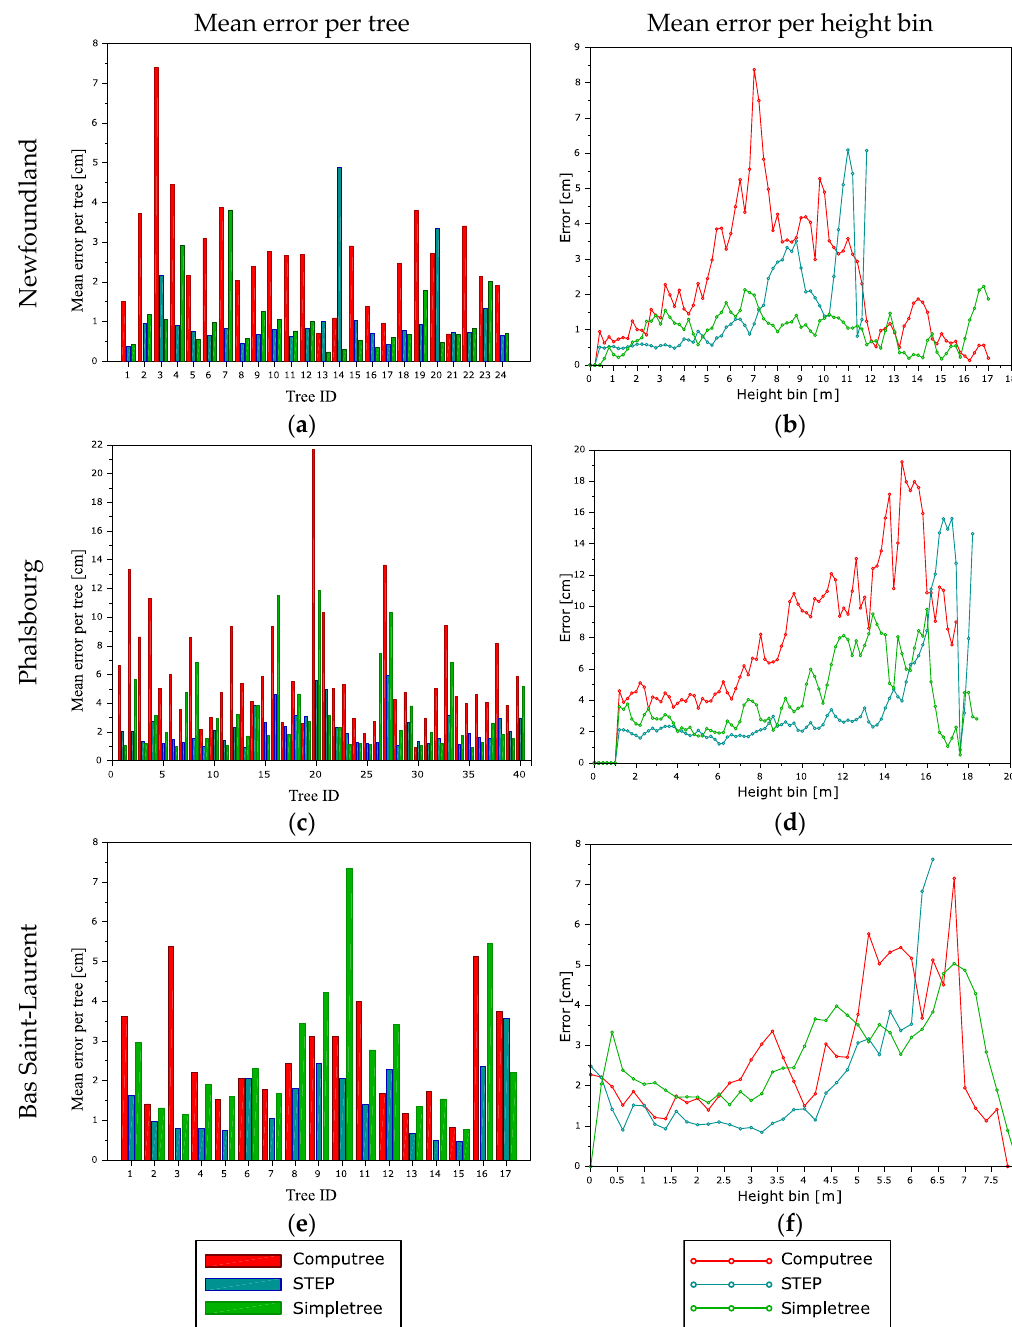
Figure 7. Stem profile estimation error for each site and each algorithm. The left figures ( a , c , and e ) show the mean profile error for each individual tree (labelled by tree ID) and each algorithm (red, green and blue). The right figures ( b , d , and f ) show the mean profile error per 20 cm bin for each site and each